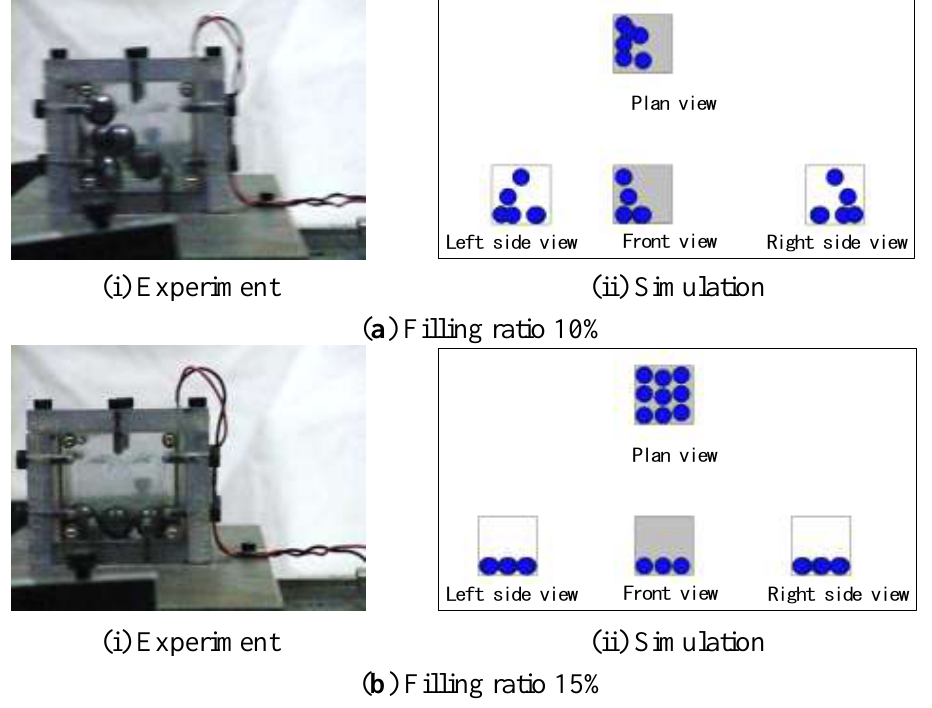
Figure 7. Flow conditions ( P d = 12.7 mm, D = 50 mm, f = 7 Hz).